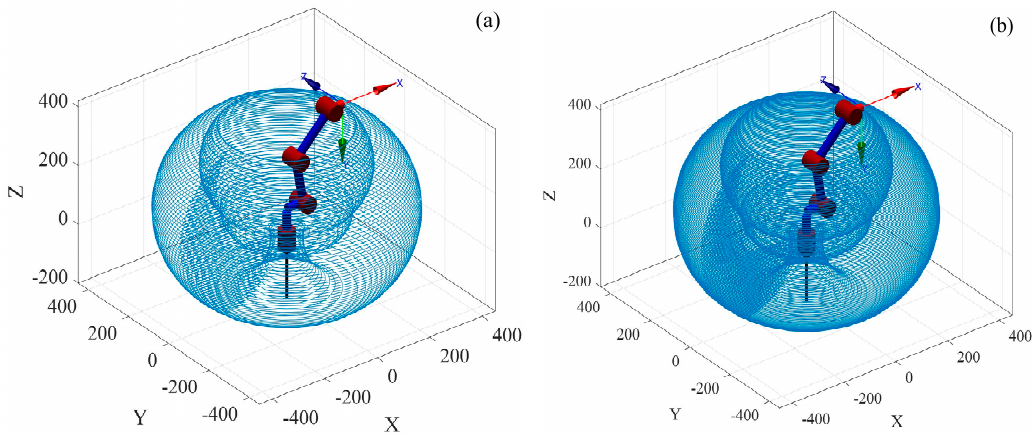
Figure 13. Workspace printing path: ( a ) setting the height to 10 mm; ( b ) set the height to 5 mm. The entire workspace was scaled by 10 times in equal proportion, so the robot could print its workspace. The origin of the base of the robot was chosen as the origin of the scaling, as shown in Figure 14. After scaling, the height dimensions became Z max = 38.2924 mm and Z min = − 17.5947 mm. The total height was 55.8871 mm. For printing, the scaled workspace model was translated to the print platform, as shown in Figure 14. First, the model was translated from the origin of the base to the origin of the WCS with vector V a = [225, − 70,12] T mm. At this time, the height of a part of the model was negative. The model was then translated with vector V p = [70, 70, 5.5947] T mm to make the model on the print platform. The printing code with joint angles of the robot was generated based on the model and the proposed multisolution method. Vector V U = V a + V p was used for the calculation of the all possible joint-angle groups. With the printing code, the scaled workspace was printed with this multijoint robot. The printing material was PLA. The layer height was set to 0.2 mm, and feed velocity was 50 mm / min. The printed model of the scaled workspace is shown in Figure 15. The results showed that the workspace visualization method produced the real workspace, and the proposed kinematics and multisolution method can be used for 3D printing with such a robot.